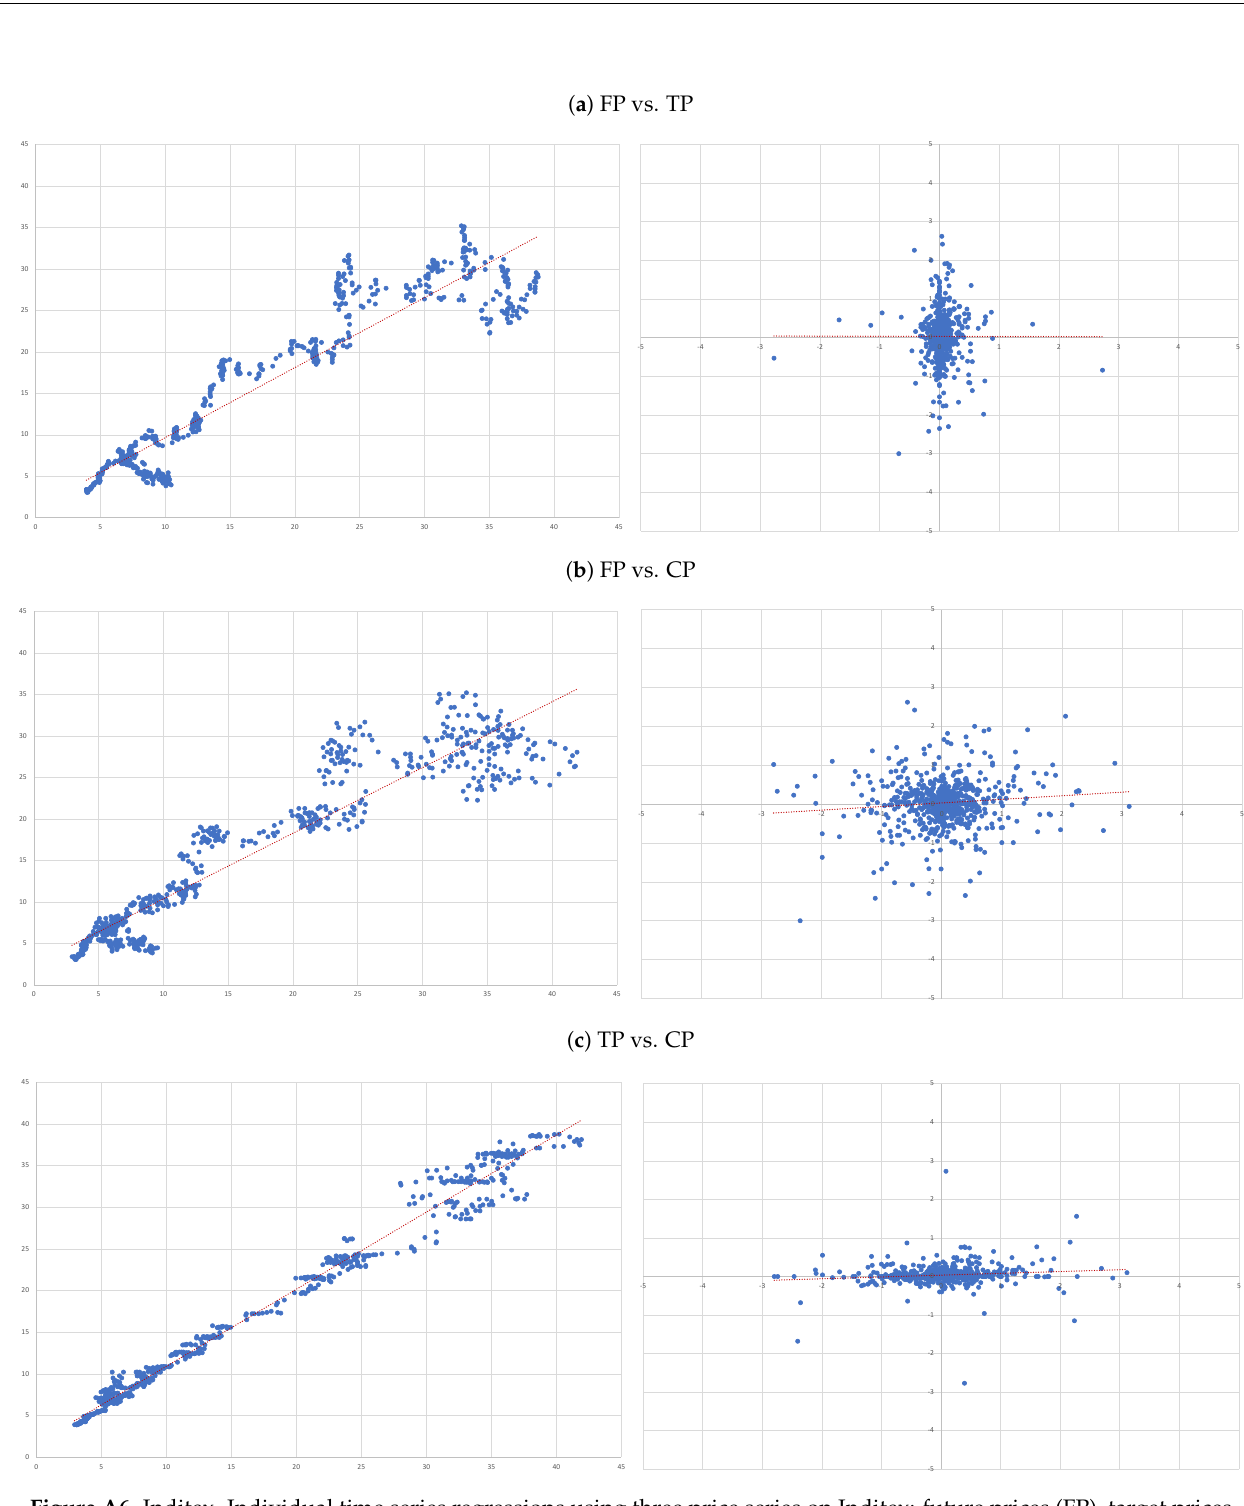
Figure A6. Inditex. Individual time series regressions using three price series on Inditex: future prices (FP), target prices (TP), and capitalised prices (CP) forecasts. On the left-hand-side are images of level regressions and on the right-hand-side are regressions in